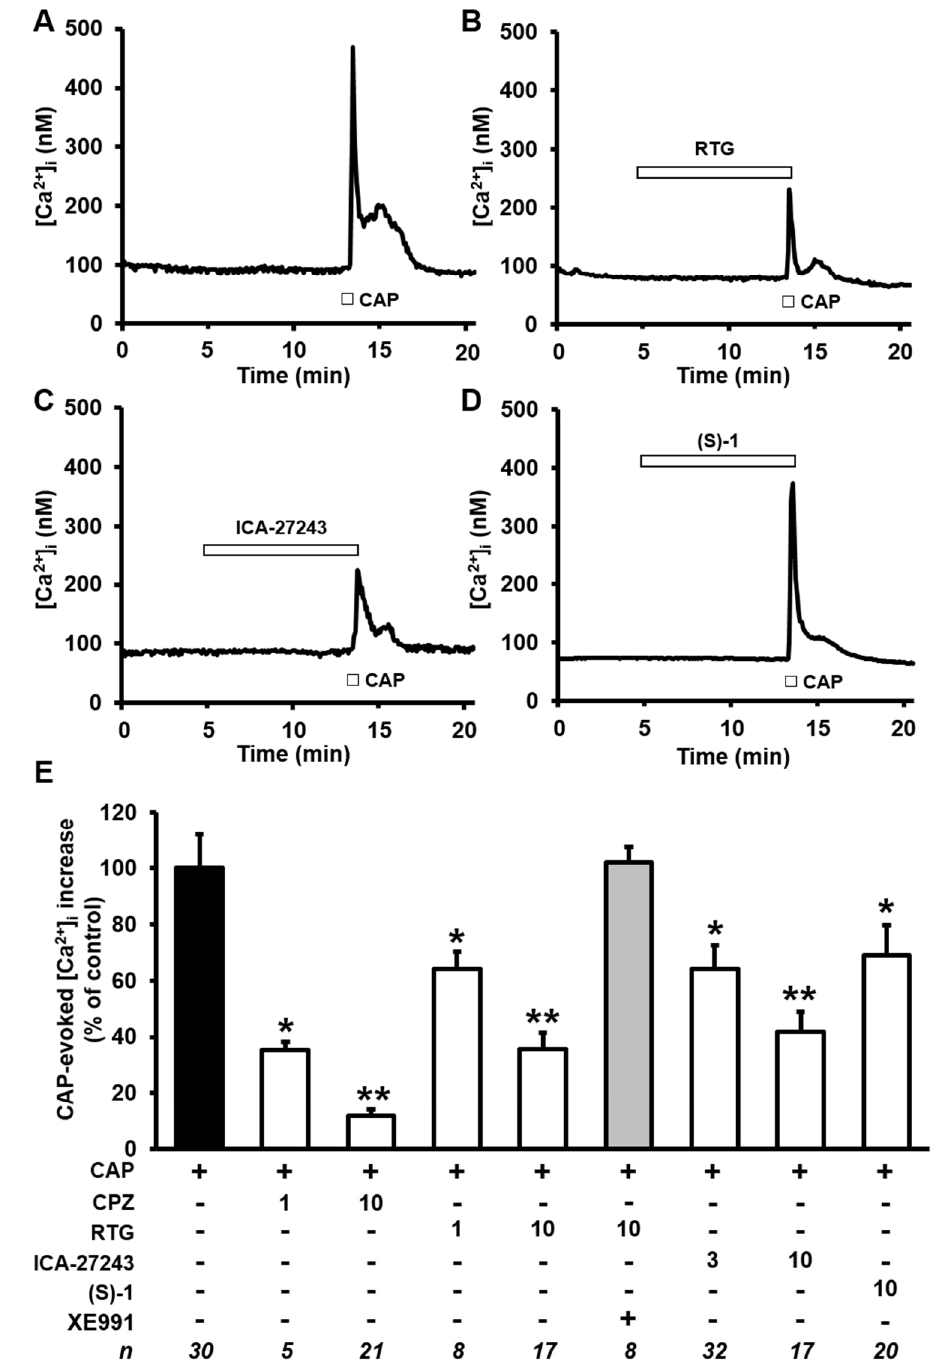
Figure 3. Effects of Kv7 modulators on capsaicin (CAP)-induced [Ca 2+ ] i responses in differentiated F11 cells. ( A , B , C , D ) Representative traces showing the effect of a single exposure to CAP (50 μM) on [Ca 2+ ] i in F11 cells incubated in control conditions ( A ) or after exposure to 10 μM of the indicated drugs ( B–D ). The length of the bars indicates the duration of each drug exposure. ( E ) Quantification of the effects of the indicated drugs (whose concentrations are reported in μM at the bottom of the panel) on CAP-induced [Ca 2+ ] i responses. Data are expressed as percent of CAP-induced [Ca 2+ ] i increases in control solution. Each bar is the mean ± SEM of separate determinations (indicated as n values at the bottom of this panel) performed in at least three experimental sessions. * or ** = p < 0.05 versus the immediately lower concentrations tested of the same drug.